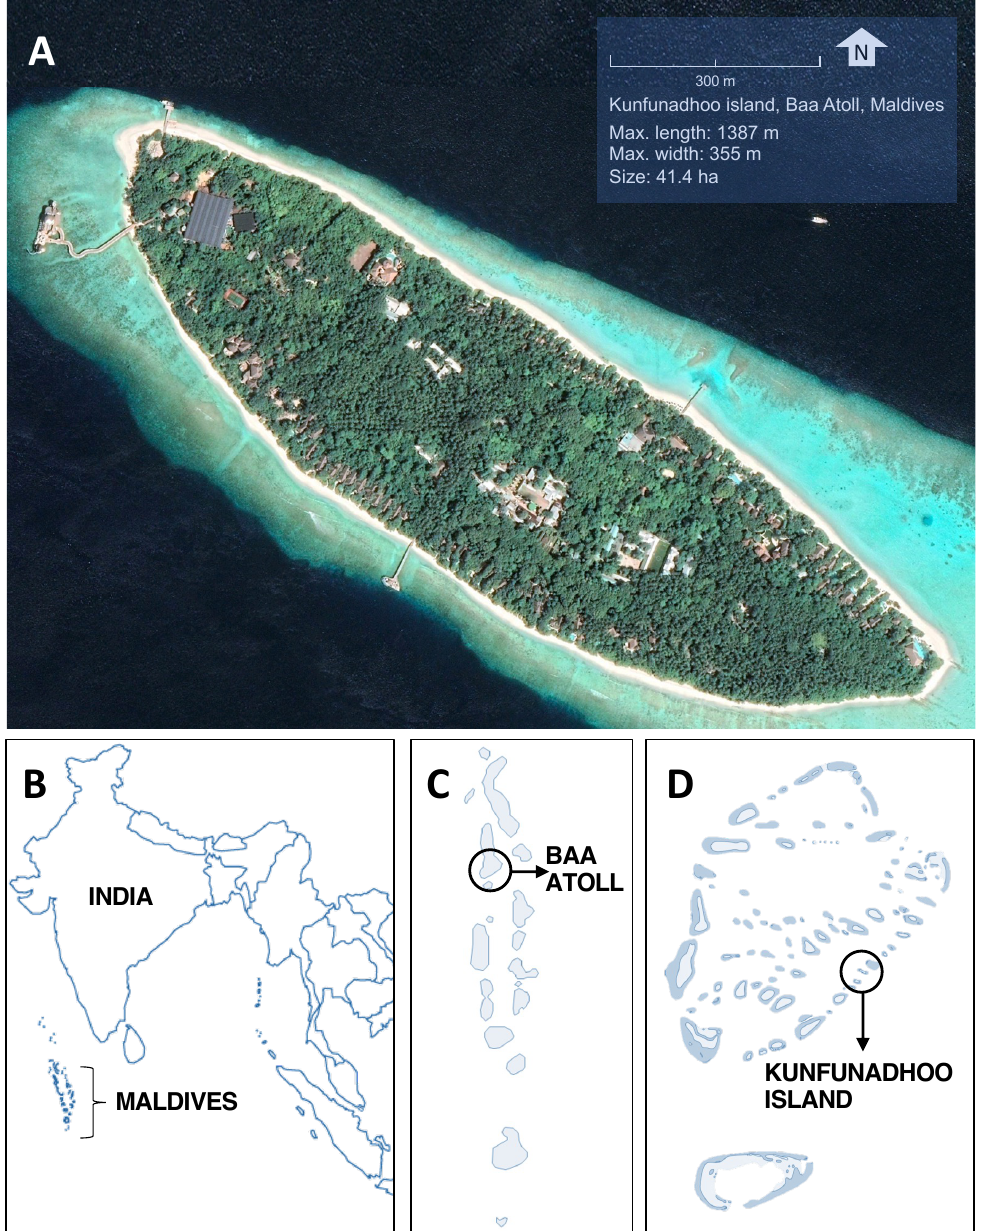
Figure 1. Location of Kunfunadhoo island. ( A ): Google Earth satellite image of Kunfunadhoo island (imagery date 27 December 2018). ( B ): Location of the Maldives. ( C ): Location of the Baa atoll. ( D ): Location of Kunfunadhoo island. The geographical center of the island is located at 5 ◦ 06 (cid:48) 42.81 (cid:48)(cid:48) N, 73 ◦ 04 (cid:48) 40.31 (cid:48)(cid:48)